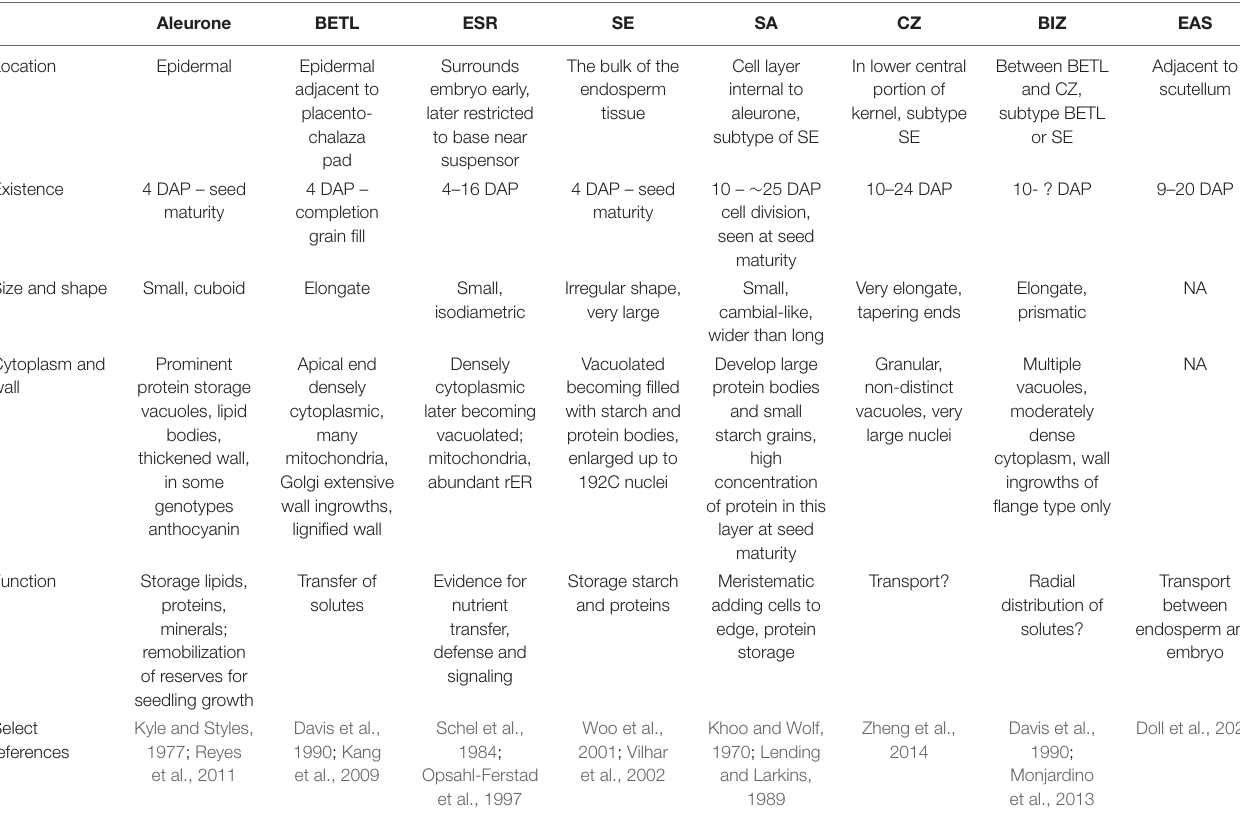
TABLE 1 | Maize endosperm cell type location, characteristics and function. Aleurone